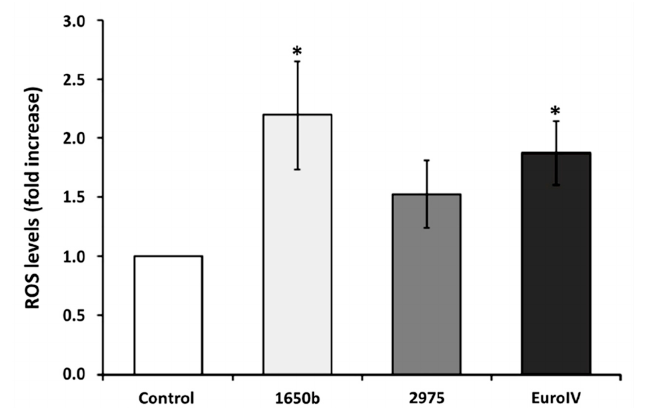
Figure 6. Analysis of the pro-inflammatory interleukin (IL)8 cytokine release in A549 cells after exposure to ZnO ( A ) and CuO ( B ) nanoparticles alone or in combination with diesel exhaust particles. * Statistically significant according to the unpaired t test; p<0.05. Reproduced with the permission